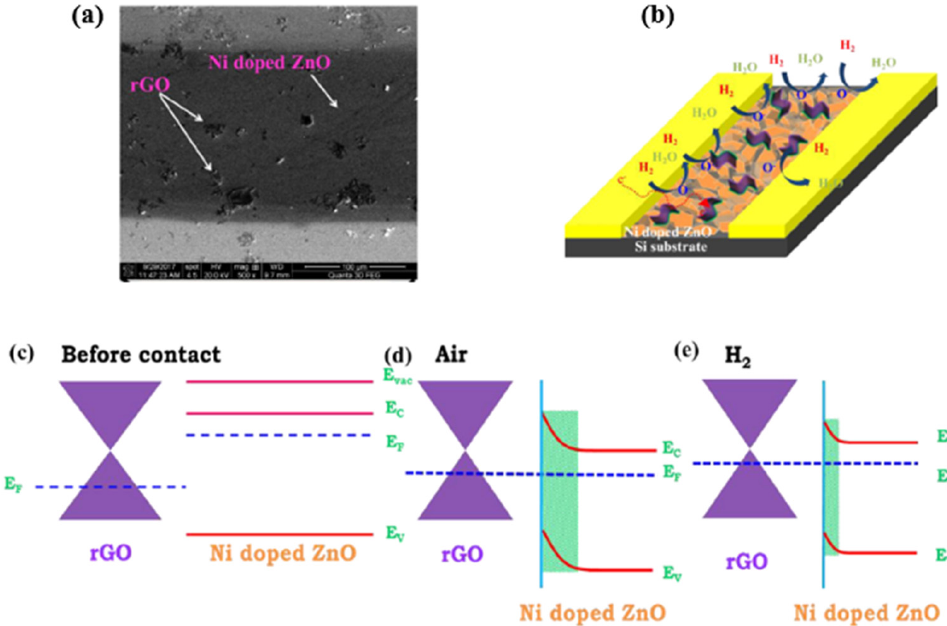
Figure 43. ( a ) SEM image of Ni-doped ZnO nanostructure and 0.75 wt% rGO loaded ZnO. Figure 44. ( a ) SEM image of Ni-doped ZnO nanostructure and 0.75 wt% rGO loaded ZnO. ( b ) Schematic diagram of the ( b ) Schematic diagram of the gas sensing mechanism in the presence of hydrogen, ( c – e ) The band gas sensing mechanism in the presence of hydrogen, ( c – e ) The band diagram illustration of rGO/ZnO heterojunction be- diagram illustration of rGO/ZnO heterojunction before contact and after contact in air and hydro- fore contact and after contact in air and hydrogen) [198]. Copyright (2018), with permission from American Chemical gen) [198]. Copyright (2018), with permission from American Chemical Society.